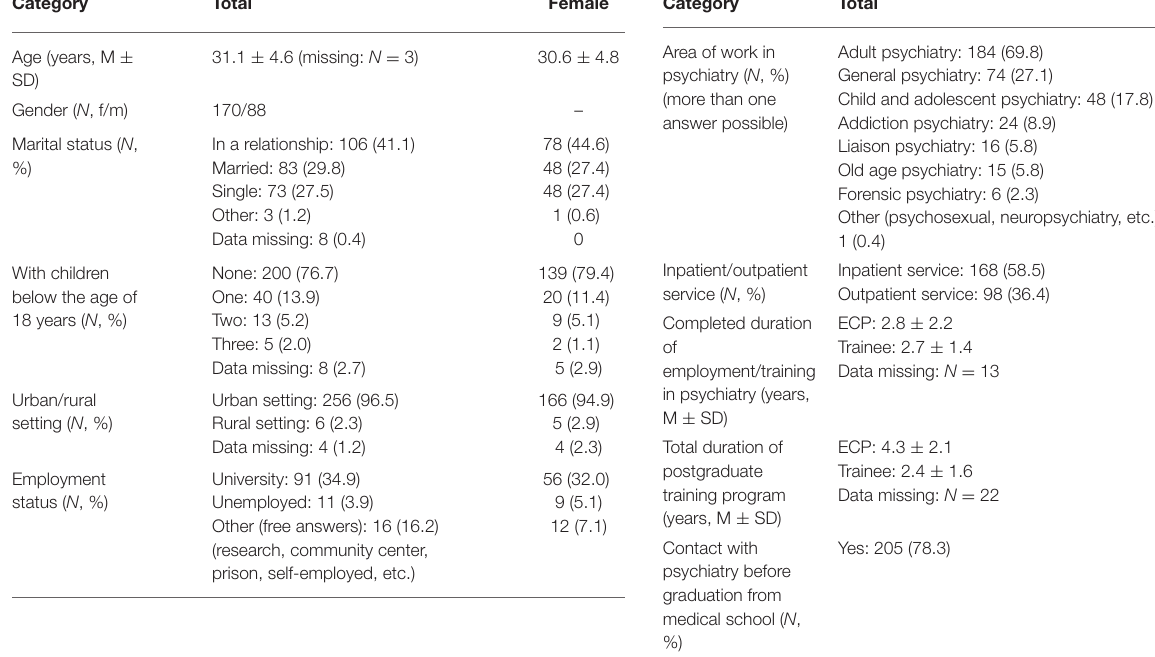
TABLE 1 | Demographic data of study sample. Category